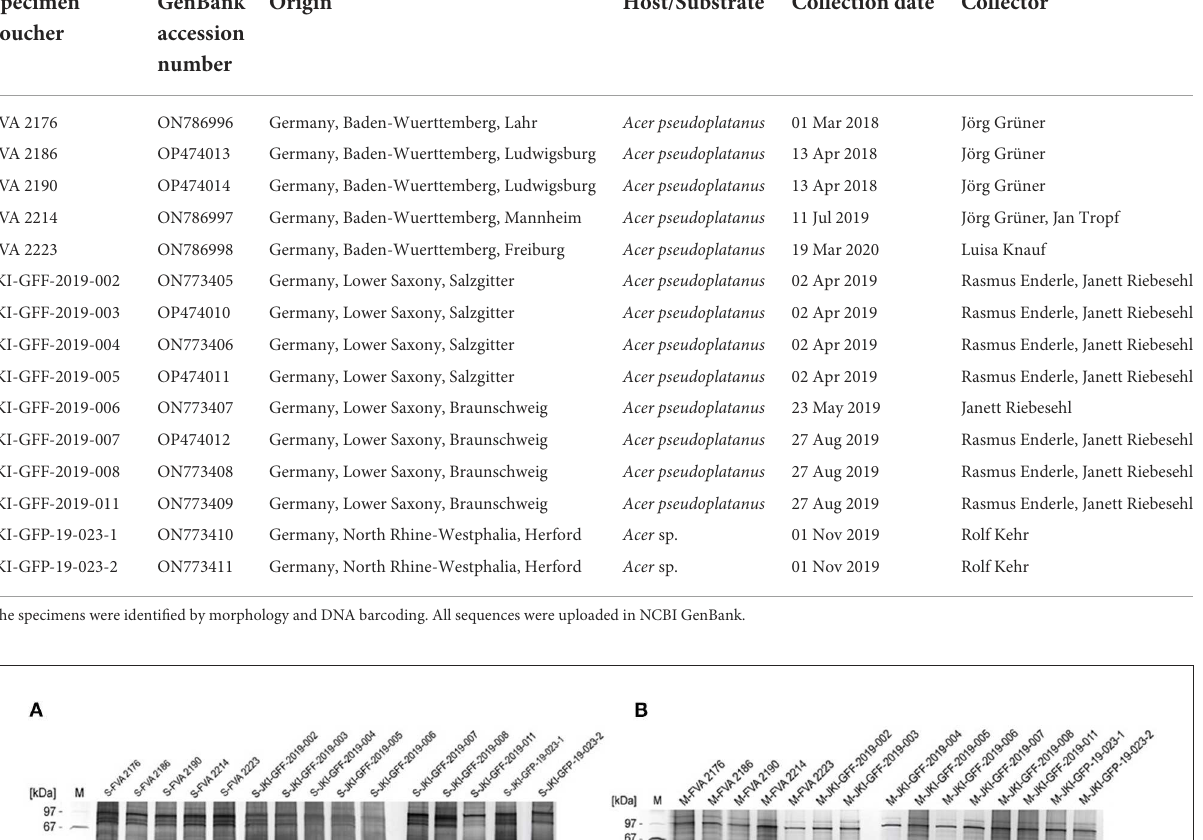
TABLE 2 Specimens and strains of Cryptostroma corticale used in this study.